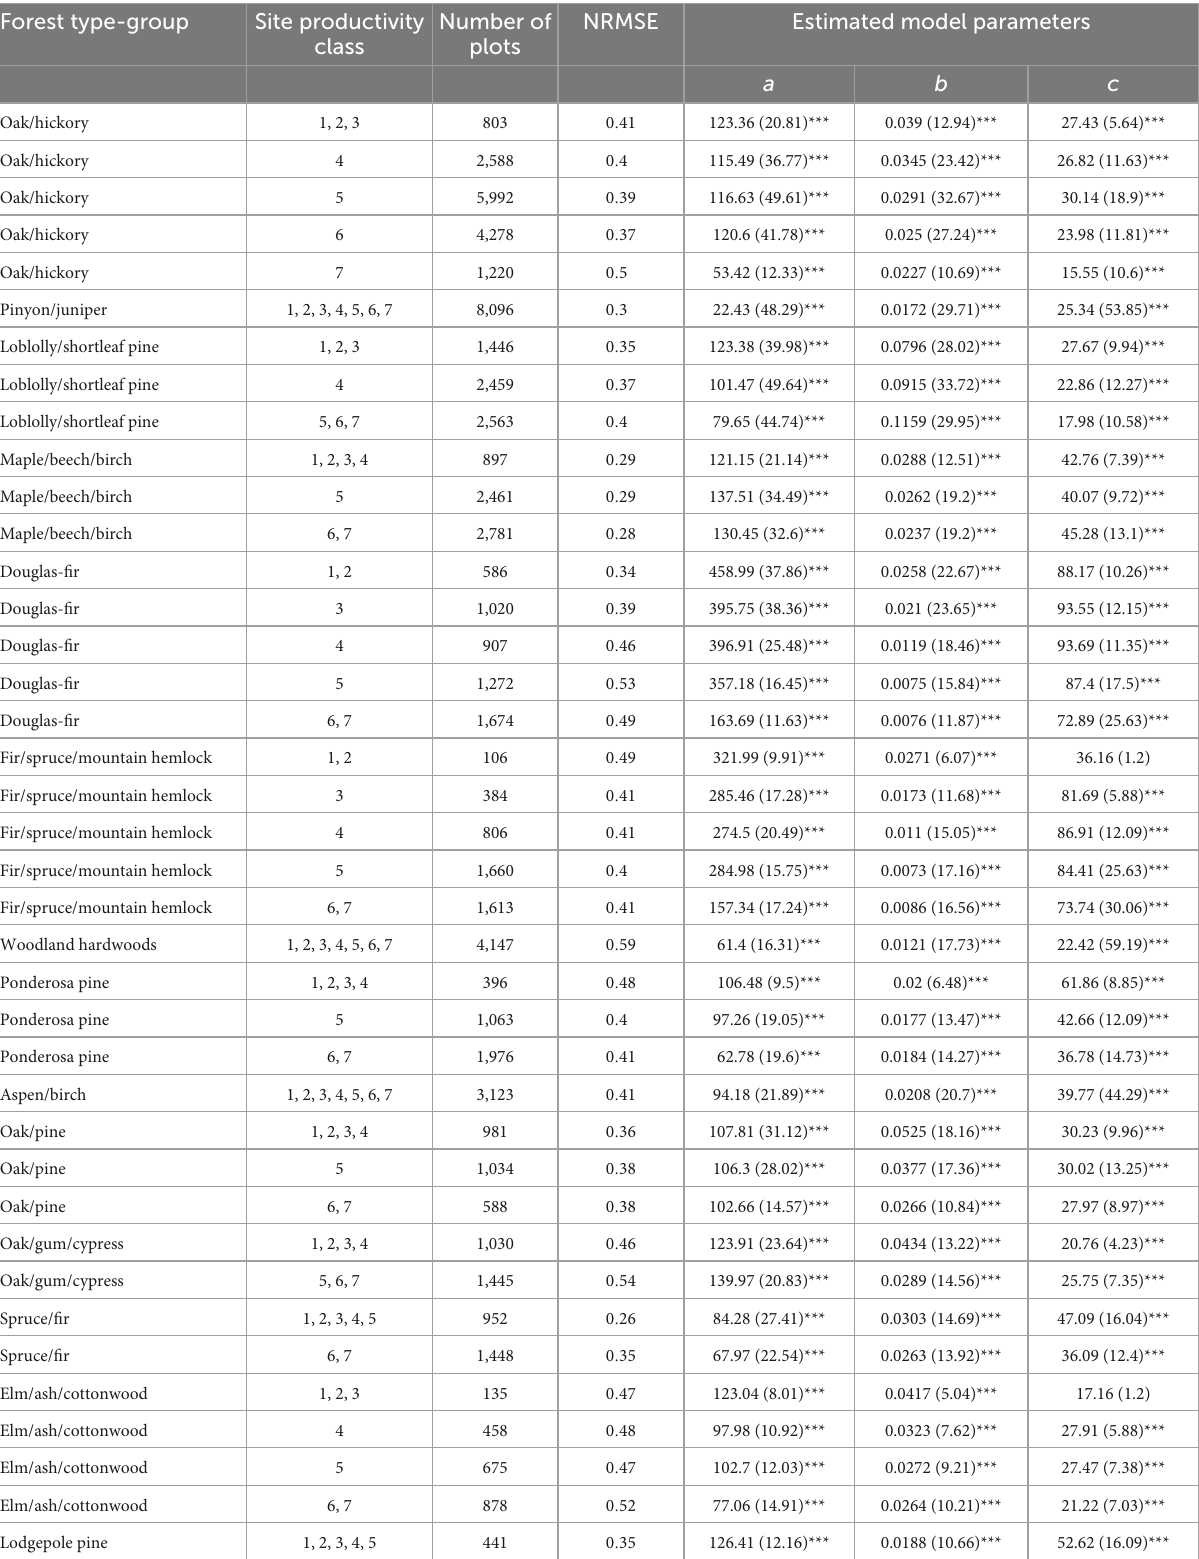
TABLE 1 Summary of sample size, accuracy, and estimated model parameters from the modified Chapman-Richards growth models within and among forest type-groups. Forest